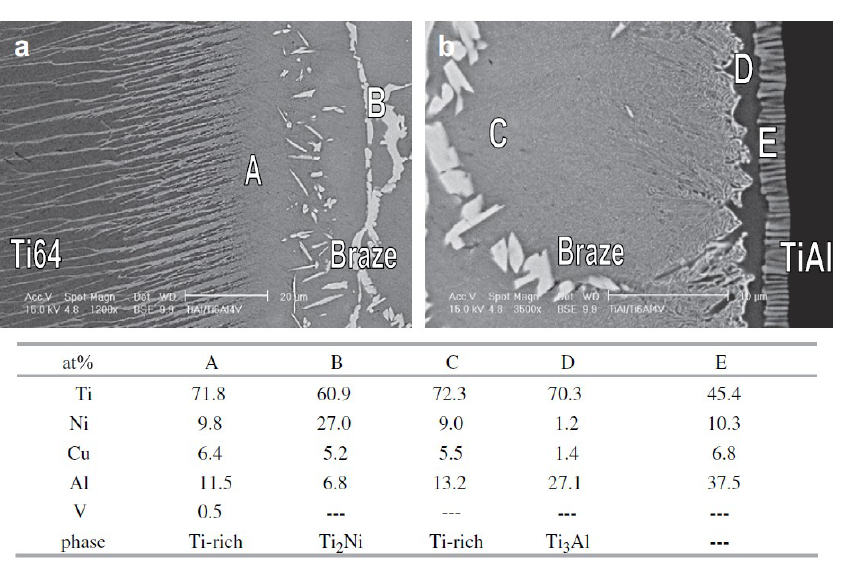
Figure 1. Scanning electron microscope (SEM) backscattered electron images (BEIs) and energy dispersive spectroscopy (EDS) chemical analysis results of infrared brazed Ti-6Al-4V and Ti50Al50 using Ti-15Cu-25Ni braze alloy at 970 °C for 300 s, ( a ) in the Ti-6Al-4V side; ( b ) in the TiAl side. (Reprinted with permission from [32]. Copyright 2008,